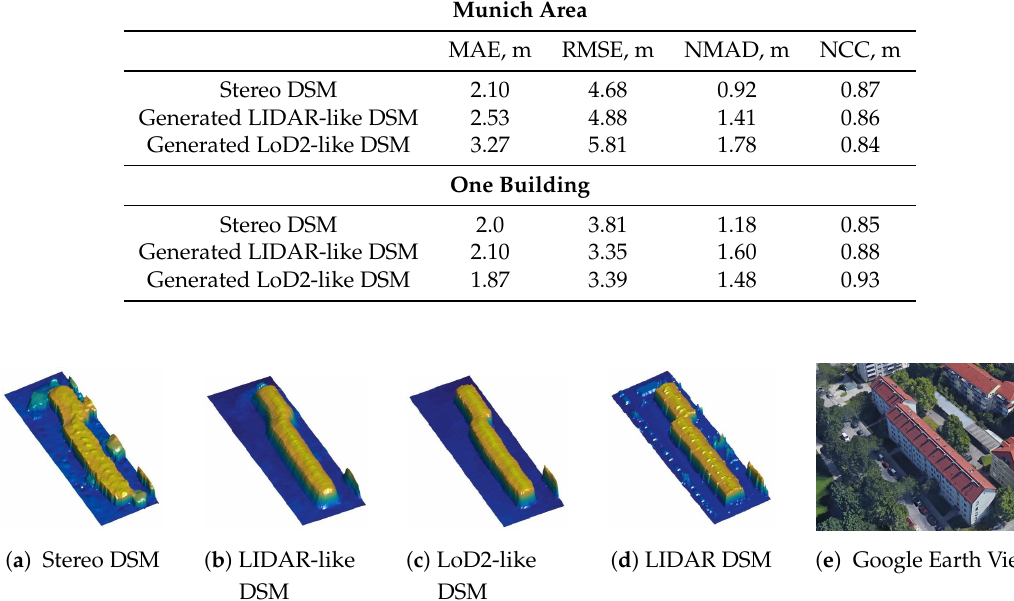
Figure 11. Example of the generated building with a refined 3D shape for Munich